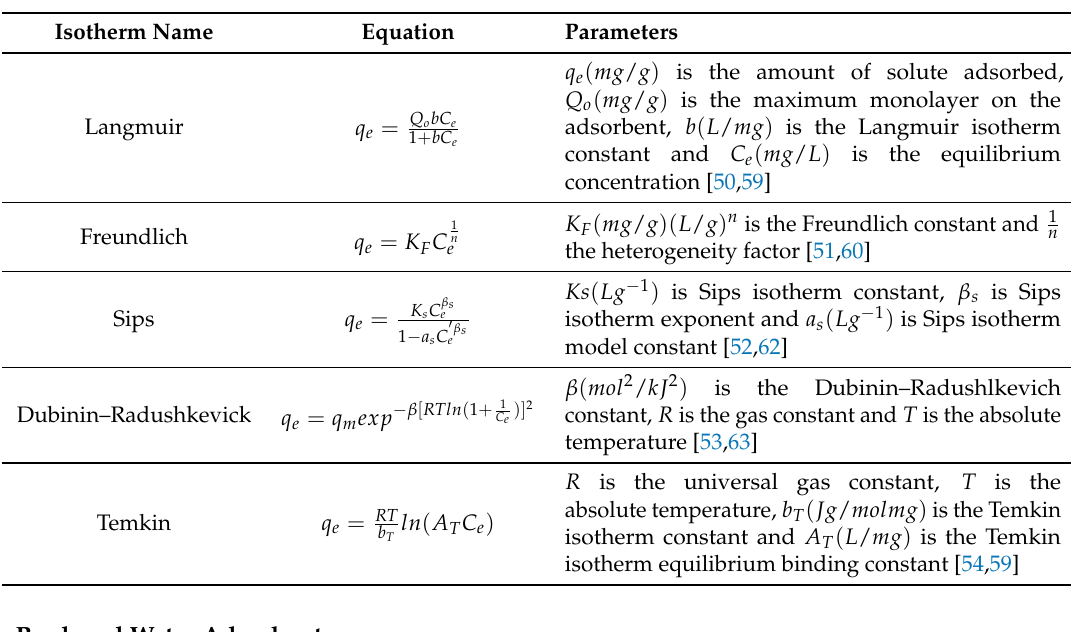
Table 4. Common isotherm models in PW.